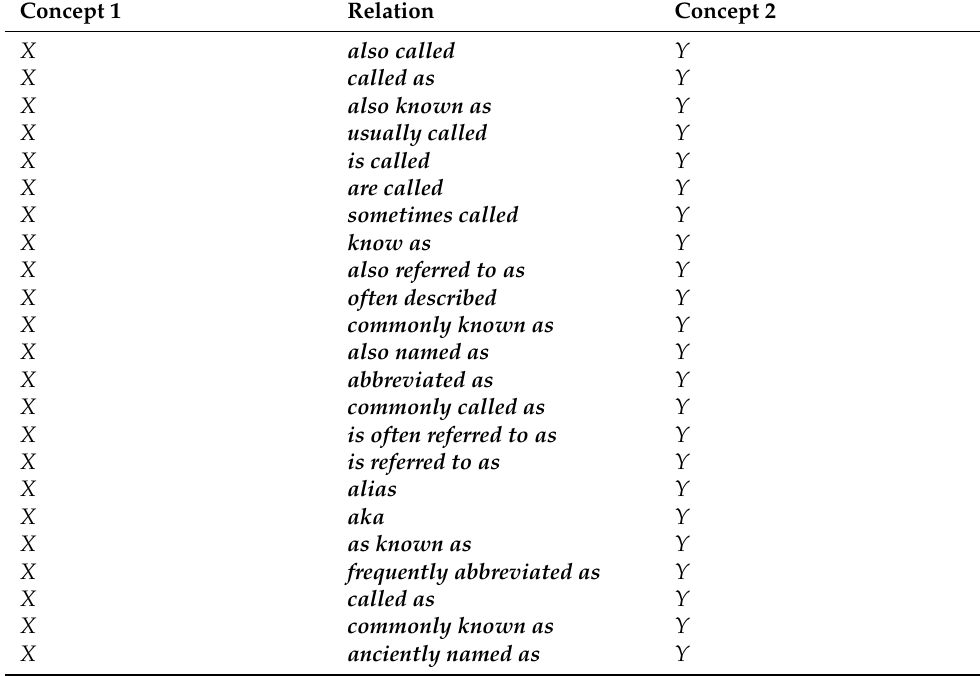
Table 1. Lexical-syntactic patterns to extract synonymy